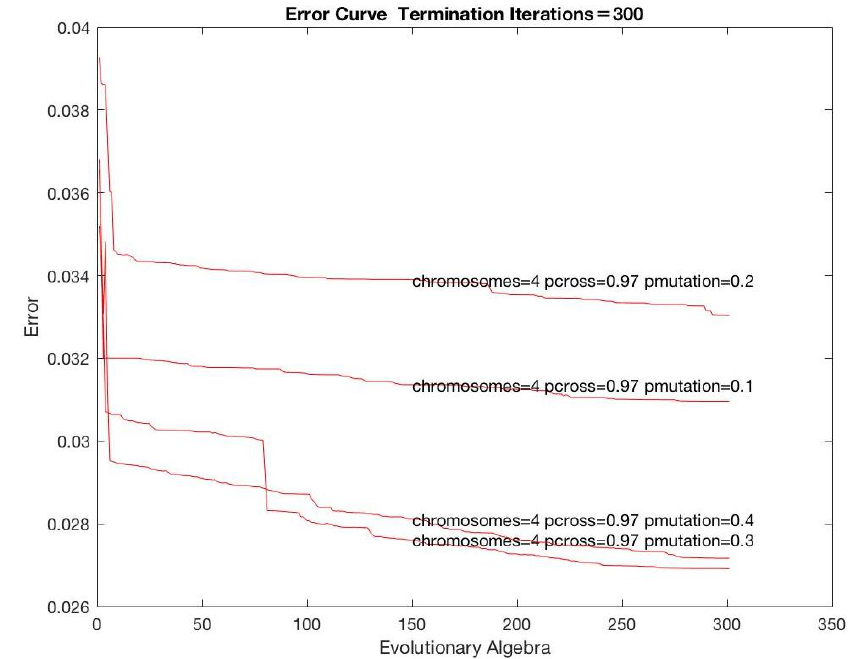
Figure 7. Effect of mutation probabilities on the objective function